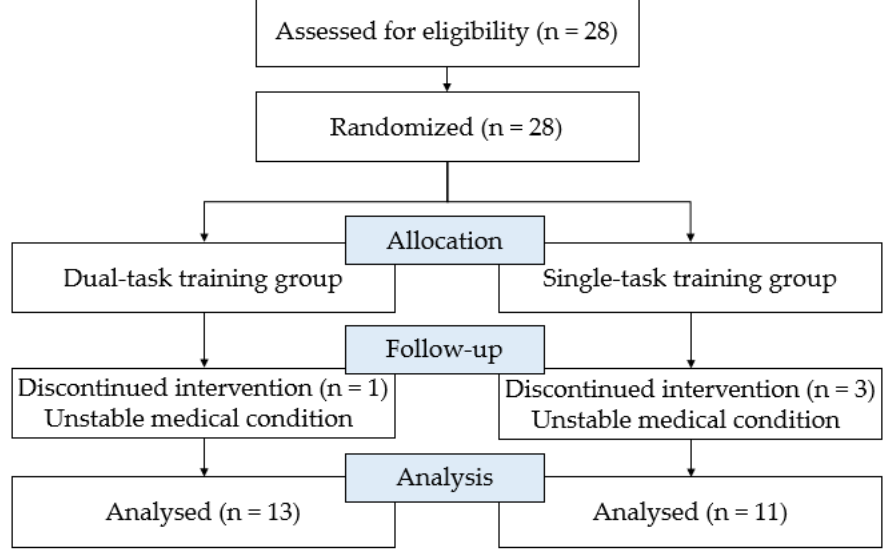
Figure 1. Flow diagram for the study.